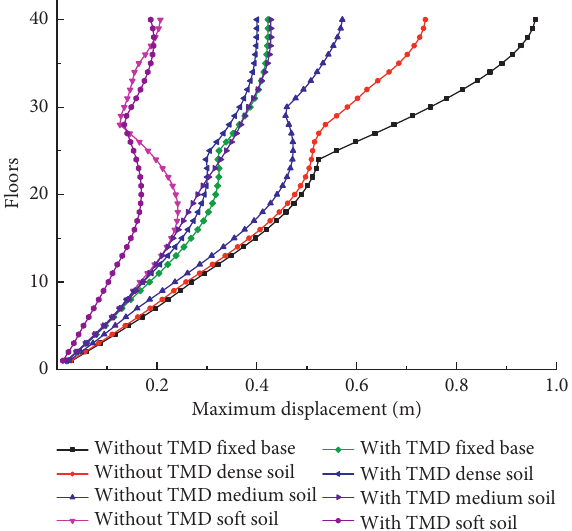
Figure 8: Tangshan earthquake maximum floor displacement comparison chart.